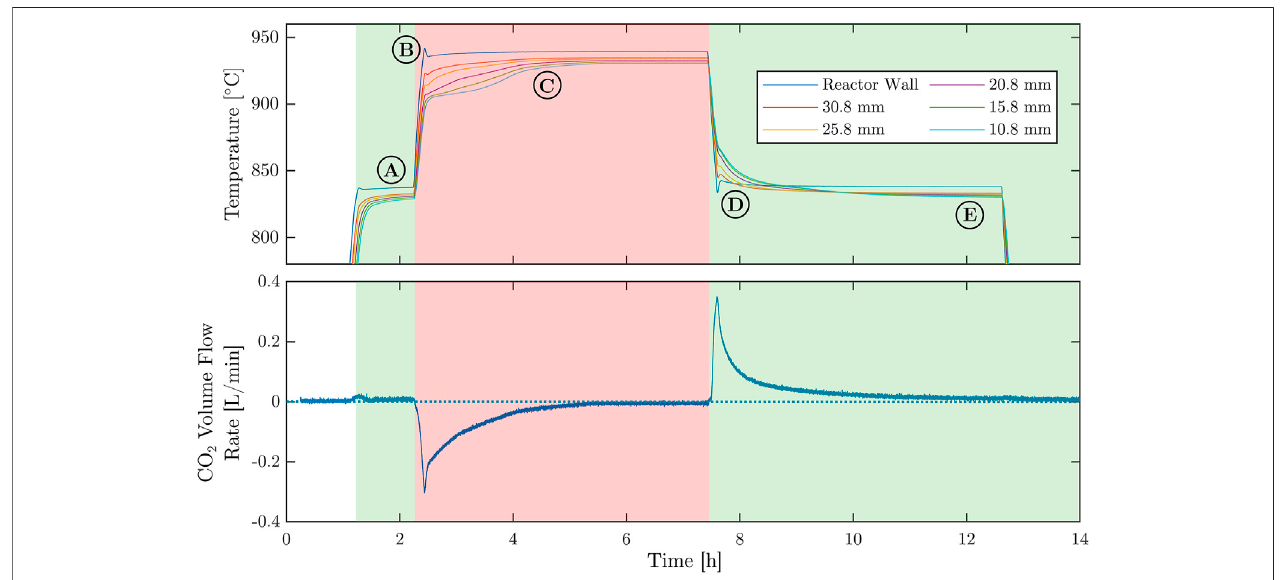
FIGURE 7 | Representative measurement of a single calcination-carbonation cycle for agglomerates, performed in the TCS reactor using a temperature-swing between 830 ° C and 930 ° C.